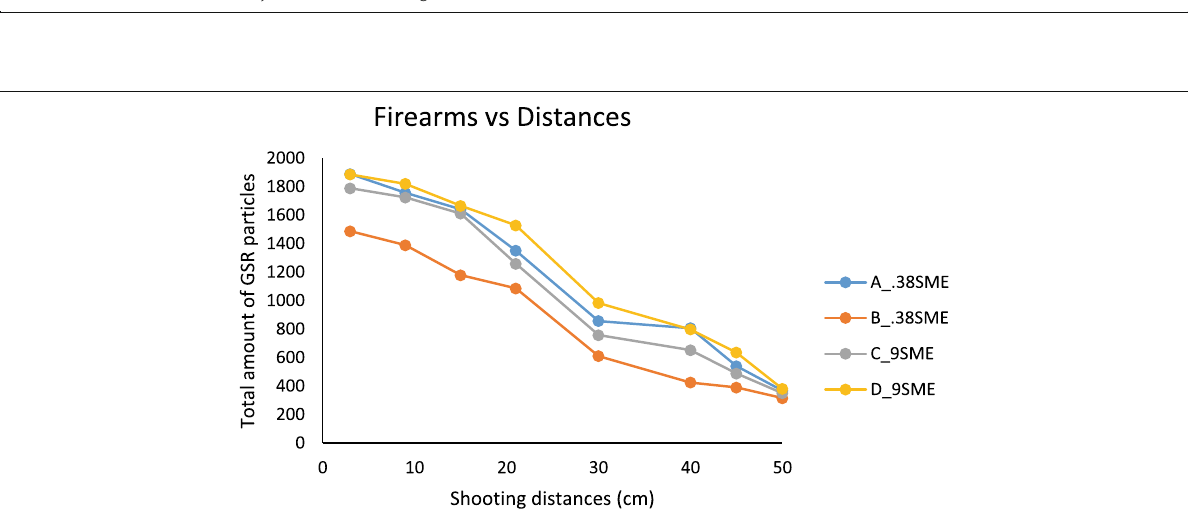
Fig. 4 Pattern distribution of soot and GSR particles: In the x -axis scale: (A_.38SME), (B_.38SME), (C_9SME) and (D_9SME) (A_.38SME), (B_.38SME), (C_9SME) and (D_9SME). In the y -axis scale: shooting distances of a 21, b 30, c 40, d 45and e 50 cm